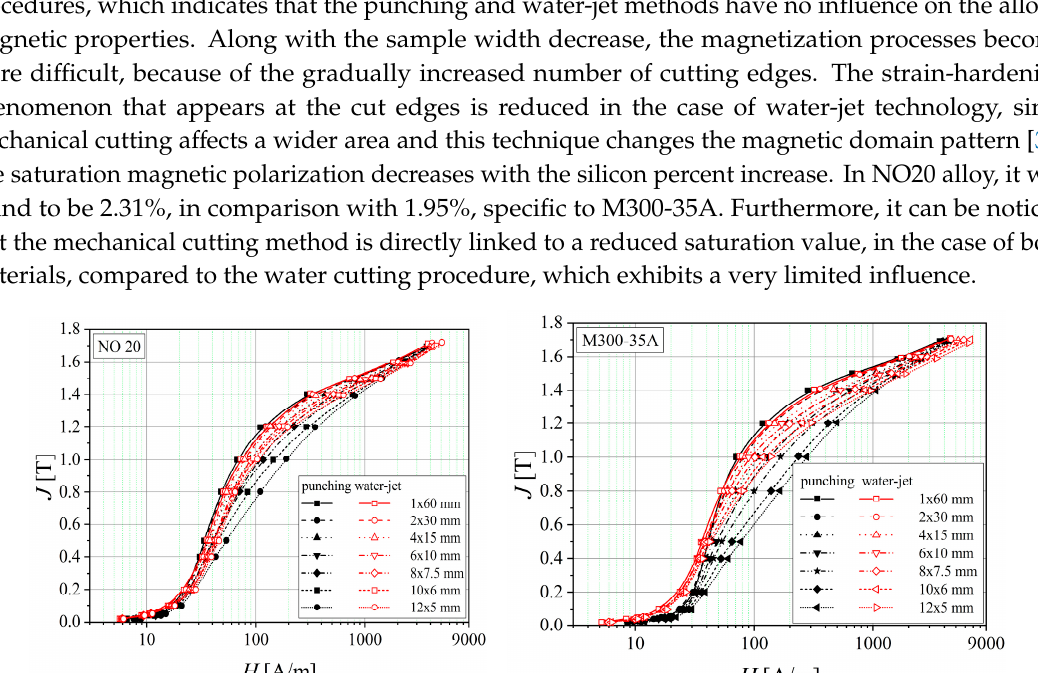
Figure 10. Normal magnetization curves of electrical steel grade NO20 ( a ) and M300-35A ( b ), in the case of two cutting technologies.